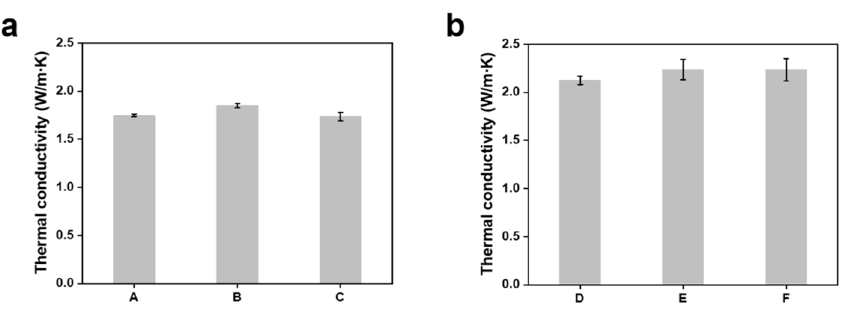
Figure 1. Thermal conductivities of thermal pads using aluminum oxide powder with ( a ) 20 wt% PDMS or ( b ) 15 wt% PDMS. The bar graph illustrating the mean and standard deviation (error bars).